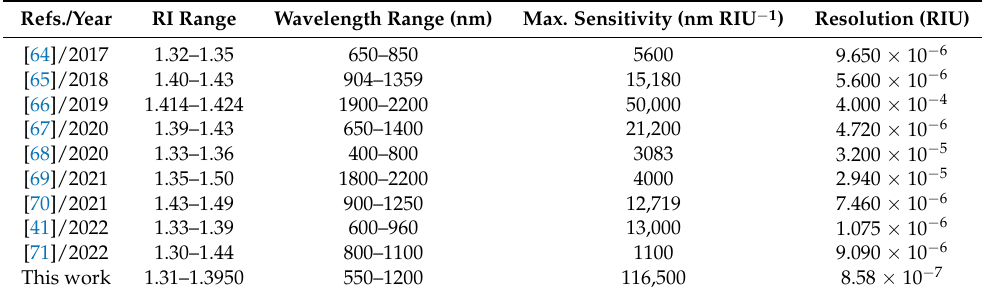
Table 6. Performance analysis comparison between the proposed SPR-PCF sensor and previously reported